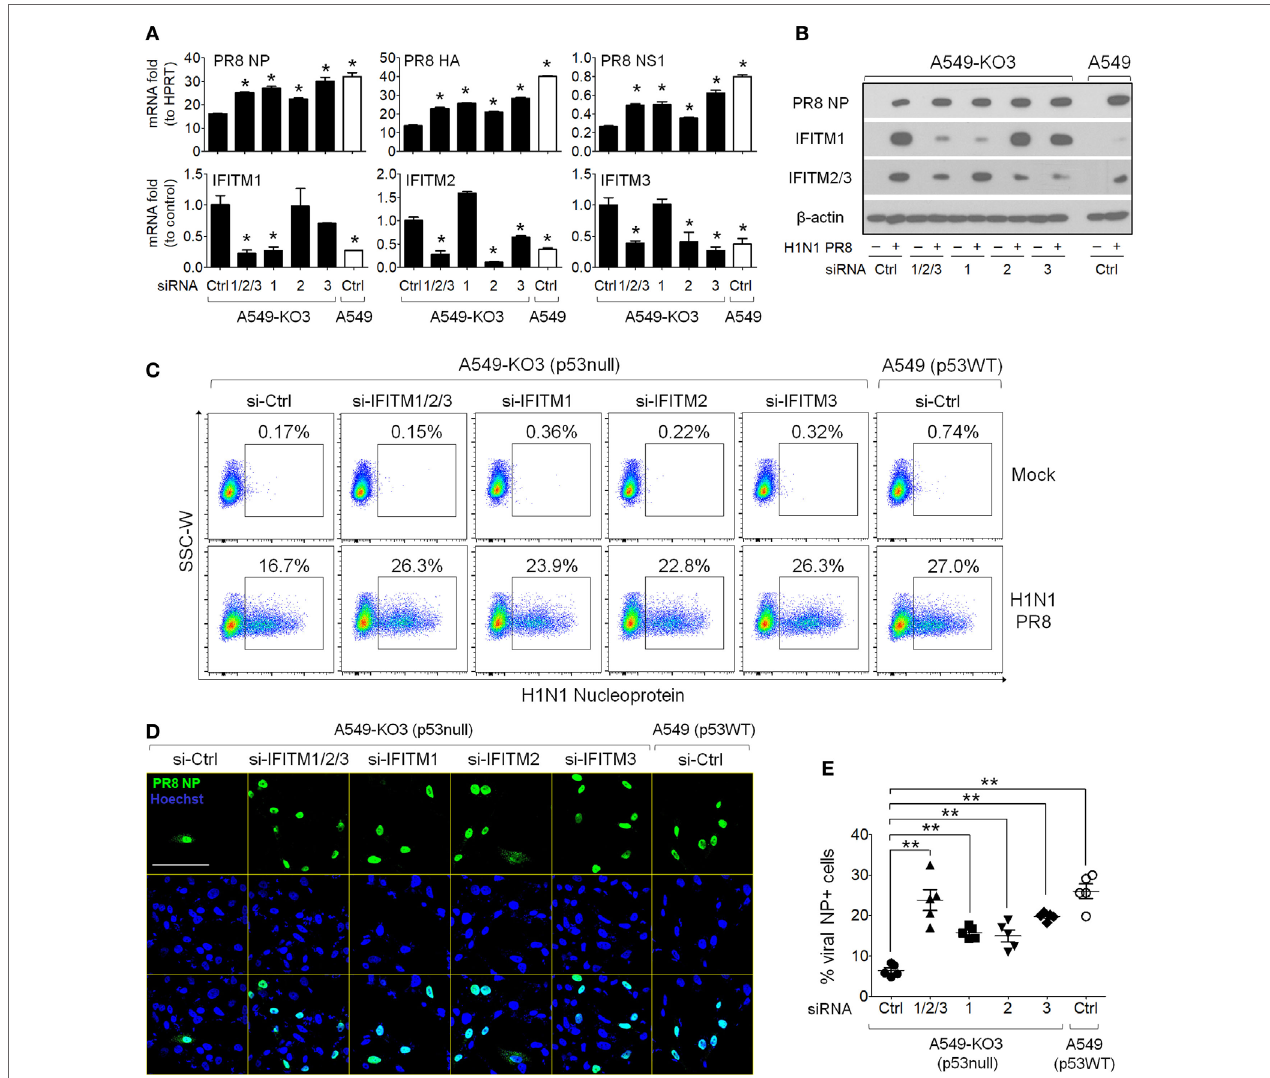
FigUre 6 | Knockdown of interferon-induced transmembrane proteins (IFITMs) in p53null A549 cells restores susceptibility to IAV infection. A549-KO3 cells were transfected with either IFITM1 (si-IFITM1), IFITM2 (si-IFITM2), IFITM3 (si-IFITM3), a combination of three short interfering RNAs (siRNAs) (si-IFITM1/2/3), or scramble control siRNA (si-Ctrl). 24 h later, cells were detached using trypsin and re-plated onto cell culture plates or μ -slides and after overnight culture, cells were infected with IAV (multiplicity of infection = 0.001) or mock control. 24 h post-infection, cells were harvested for different assays and the RNA and protein lysates were also collected. A549 cells transfected with control siRNA were also included as a benchmark reference. (a) Real-time quantitative PCR analysis of IFITM1, IFITM2, IFITM3, IAV nucleoprotein (NP), IAV hemagglutinin (HA), and IAV non-structural protein 1 (NS1) gene expression level in IAV-infected cells pretreated with different siRNAs. For IFITM1, IFITM2, and IFITM3, expression data were normalized to that of the reference gene HPRT, and then to control siRNA transfected A549-KO3 cells, while for NP, HA, and NS1 gene expression, data were normalized to an HPRT control. * p < 0.05. (B) Western blot analysis of IAV NP, IFITM1, and IFITM2/3 protein expression in IAV-infected p53WT A549 and p53null A549-KO3 cells pretreated with different siRNAs. β -actin blotting was used as a loading control. (c) Flow cytometry analysis of Mock- or IAV-infected p53WT A549 and A549-KO3 cells pretreated with different siRNAs. Each population of NP-positive cells was boxed and their percentages were shown. (D) Representative immunofluorescence microscopy images of IAV-infected A549-KO3 cells pretreated with different siRNAs. IAV NP was detected using a FITC-labeled anti-NP antibody, and cell nuclei were stained with Hoechst 33342. Scale bar, 50 µm. (e) Percentages of NP-positive cells from IAV-infected A549-KO3 cells pretreated with different siRNAs. Five areas were randomly selected for image capture and the% of NP-positive cells was calculated by the number of NP-positive cells (green) as a proportion of total cell numbers, reflected by Hoechst staining (blue). * p <